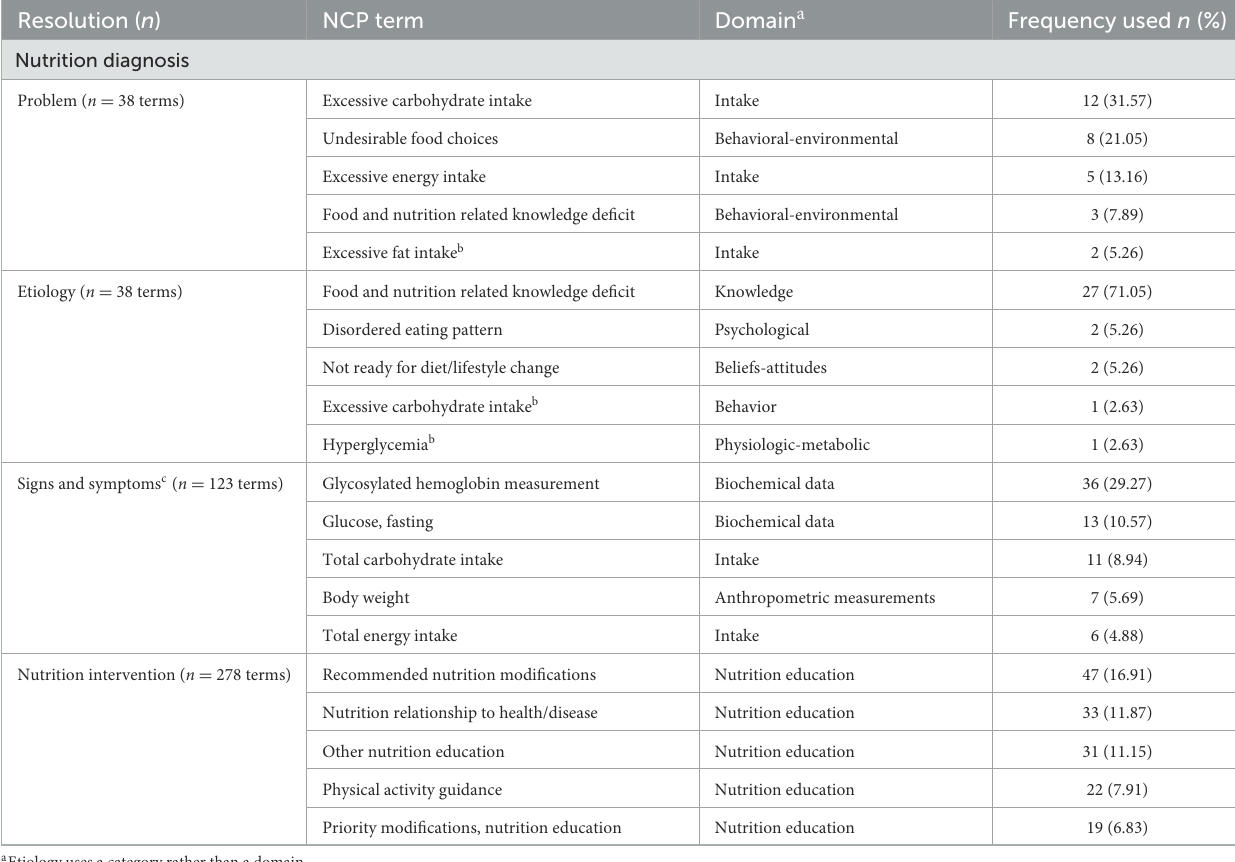
TABLE 1 Distribution of Nutrition Care Process (NCP) standardized terminology used for patients with Type 1 and Type 2 diabetes mellitus that achieved nutrition diagnosis resolution ( n = 38